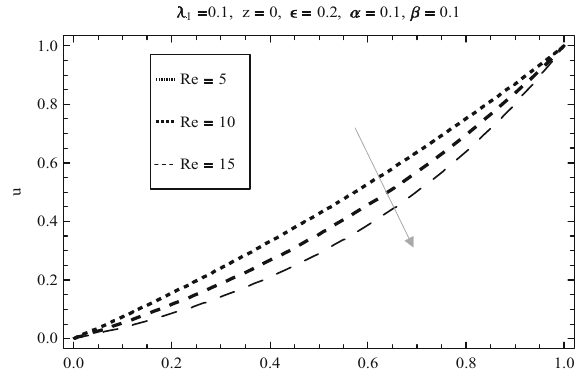
Fig. 5 Velocity component u along y for different values of Re